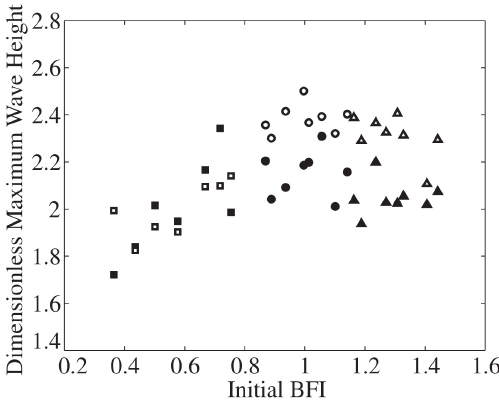
Fig. 9. Steepness of maximum wave height vs. initial